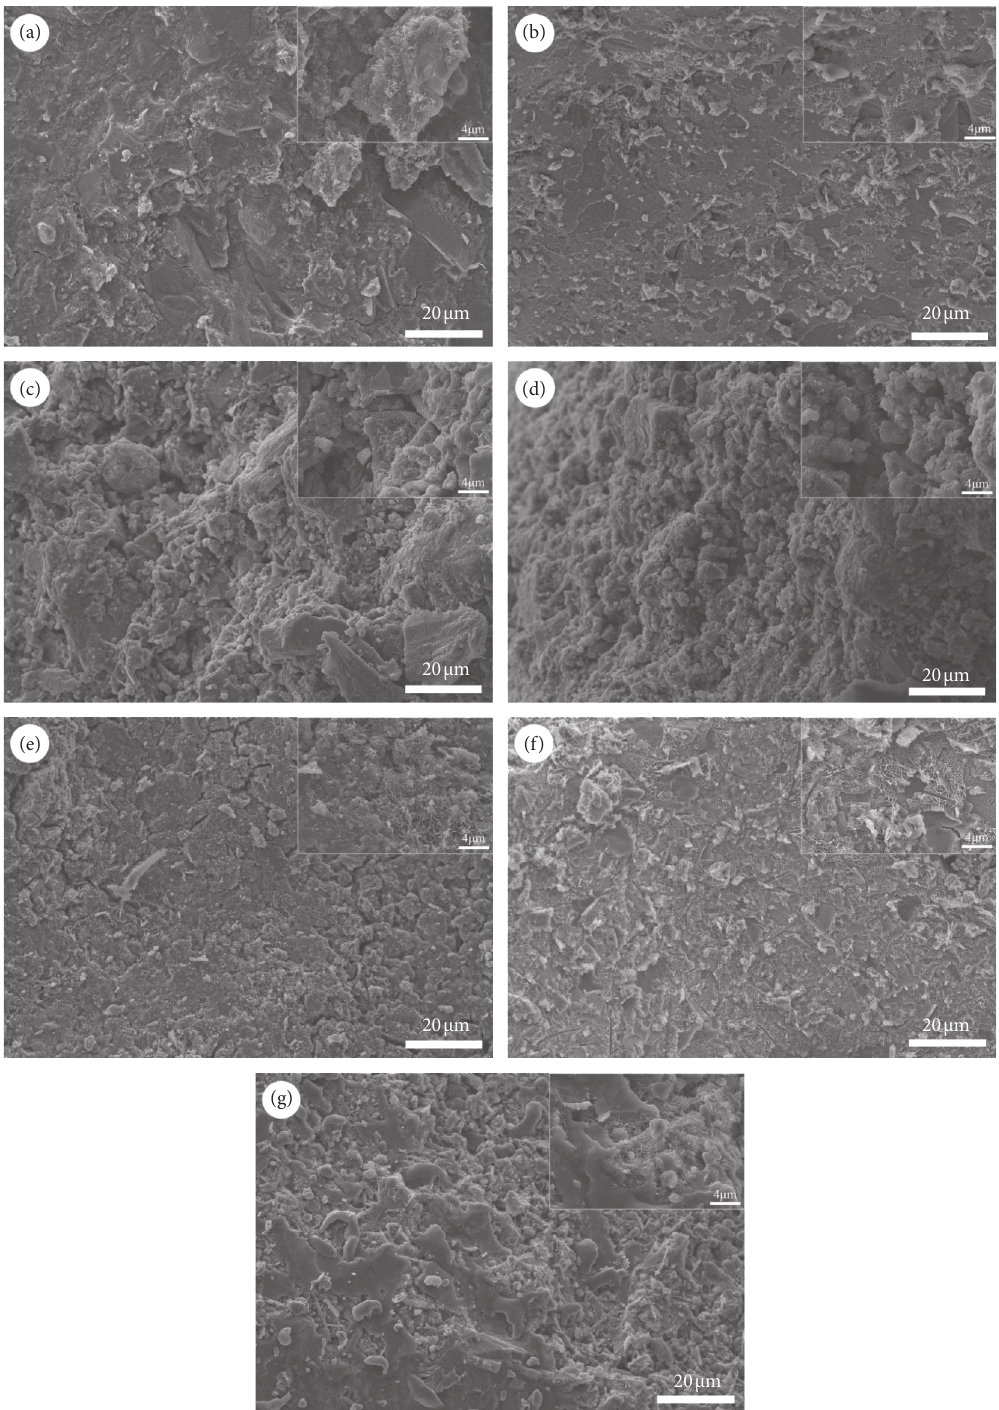
Figure 10: SEM image of alkali-activated mortar in various coating methods. (a) C; (b) O100; (c) O200; (d) O300; (e) T100; (f) T200; (g)